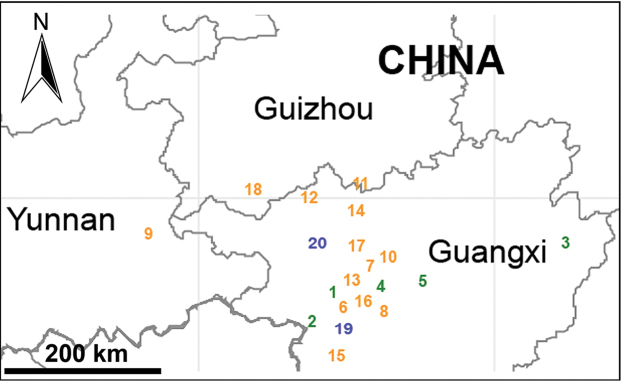
Distribution records of Pinelema spp., the adunca-group (green), the bailongensis-group (orange), and the cunfengensis-group (blue): 1P.
adunca comb. nov. 2P.
qingfengensis3P.
renalis comb. nov. 4P.
tortutheca comb. nov. 5P.
yashanensis comb. nov. 6P.
bailongensis7P.
cheni8P.
cordata9P.
curcici10P.
huoyan11P.
liangxi12P.
lizhuang13P.
strentarsi14P.
wangshang15P.
wenyang16P.
xiushuiensis17P.
yunchuni18P.
zhewang19P.
cunfengensis20P.
spirae comb. nov.